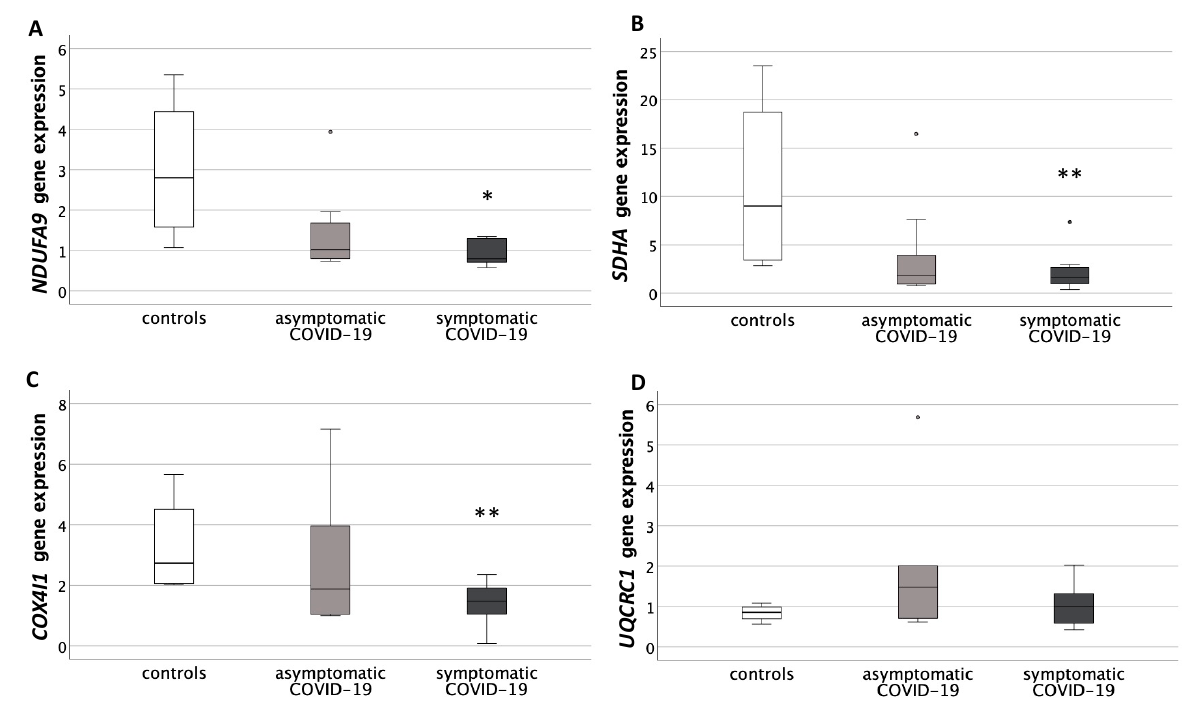
Figure 3. Expression levels of genes belonging to the respiratory chain subunits, within the inner membrane of mitochondria, in placentas from healthy control pregnancies and mothers infected with SARS-CoV-2 during the third trimester of pregnancy. ( A ) Placental NADH-dehydrogenase-1 α subcomplex 9 ( NDUFA9 , complex I) gene expression levels. Data were significantly different among the three groups (Kruskal–Wallis test, p < 0.05). * p < 0.05 vs. controls (Mann-Whitney U test). ( B ) Placental Succinate DeHydrogenase complex subunit A ( SDHA , complex II) gene expression levels. Data were significantly different among the three groups (Kruskal-Wallis test, p < 0.05). ** p = 0.01 vs. controls (Mann-Whitney U test). ( C ) Placental Cytochrome c OXidase subunit IV Isoform 1 ( COX4I1 , complex IV) gene expression levels. Data were not significantly different among the three groups. ( D ) Placental UbiQuinol-Cytochrome c Reductase Core protein I ( UQCRC1 , complex III) gene expression levels. Data were significantly different among the three groups (Kruskal–Wallis test, p < 0.05). ** p = 0.01 vs. controls (Mann-Whitney U test). Round circles are values that differ of more than 2 standard deviations from the median value.